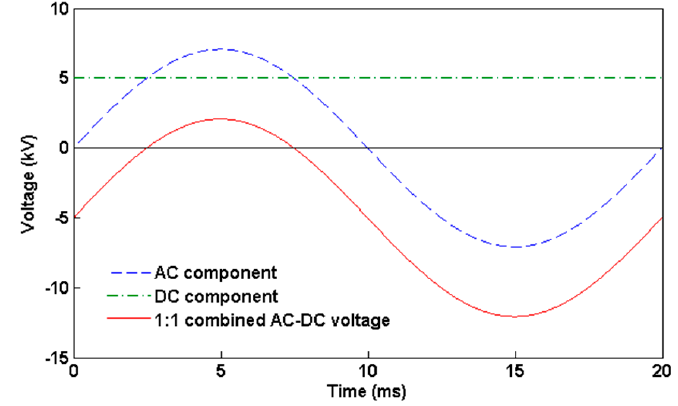
Figure 3. The applied voltage waveform.